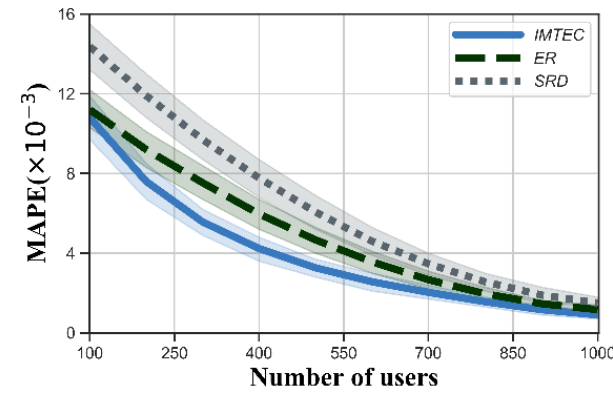
Figure 2. Mean Absolute Percentage Error (MAPE) versus the number of users.